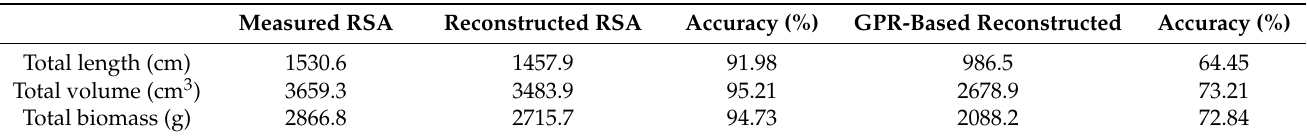
Table 4. Accuracy of reconstructed root system architecture (RSA) in terms of total length, volume, and biomass assessed by comparison with measured RSA.